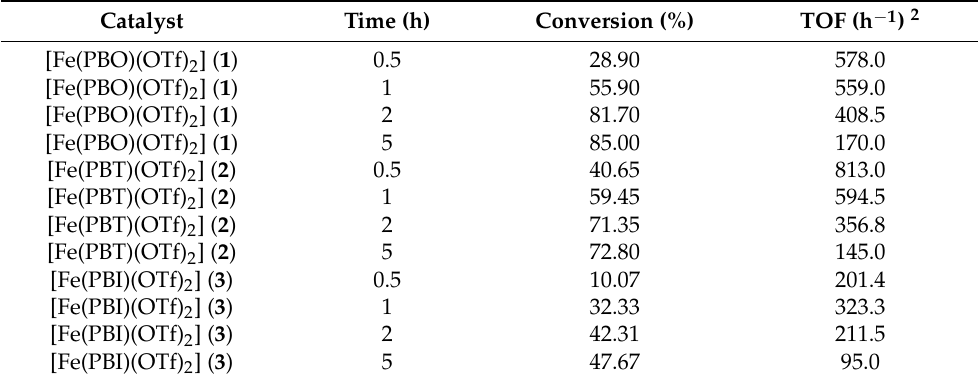
Table 1. Comparison of the efficiency for the iron(II)-catalyzed Baeyer–Villiger oxidation of cyclohex- anone by molecular oxygen in the presence of benzaldehyde 1